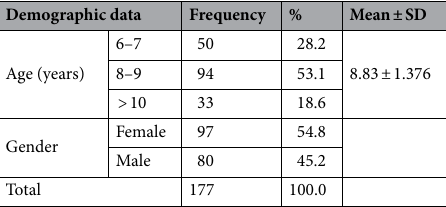
Table 2. Demographic data of the study population.